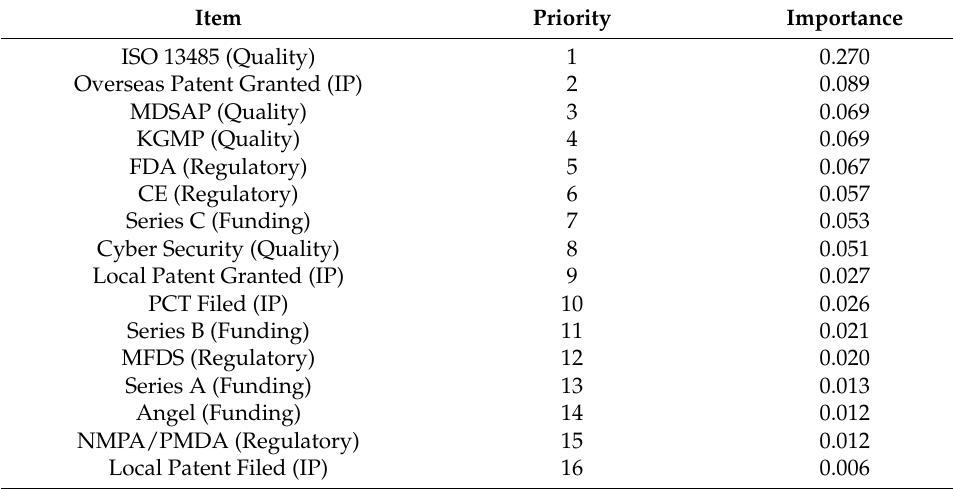
Table 3. Results of internal conditions (candidate’s